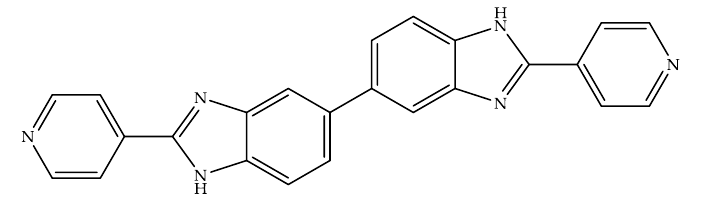
Figure 4. Chemical structure of